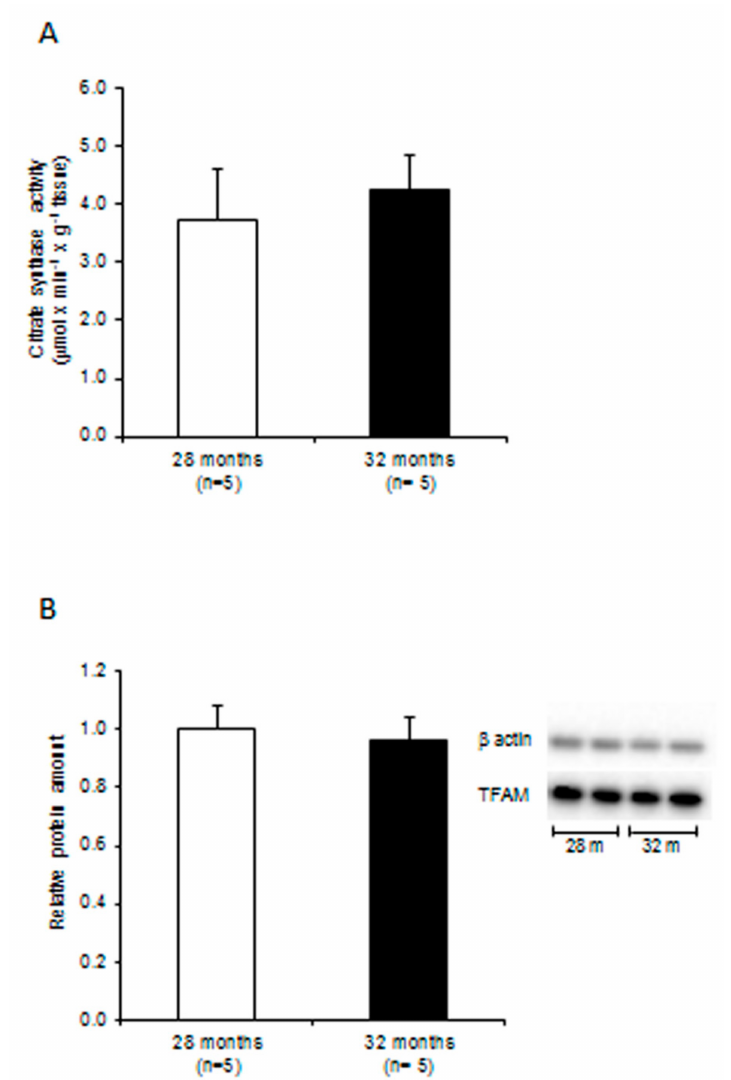
Figure 1. Citrate synthase activity and mitochondrial transcription factor A (TFAM) relative amount in liver from 28- and 32-month-old rats. ( A ) Citrate synthase activity. Bars represent the mean value and SEM of experiments performed in quadruplicate. ( B ) Relative amounts of TFAM. Bars represent the mean and standard error of the mean (SEM) of the relative TFAM / β -actin value, obtained by densitometry analysis of the results from triplicated western blot experiments, from each 28- and 32-month-old rat. The comparison was made with respect to the value of the 28-month-old rats, fixed as 1. Right panel: representative western blot carried out in two rats from each assayed group. The bands, from top to bottom, show the signals from β -actin and TFAM; n = number of analyzed